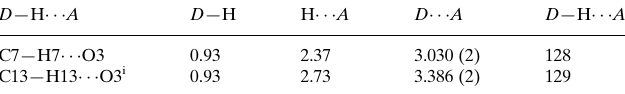
Hydrogen-bond geometry (A˚ , (cid:2)